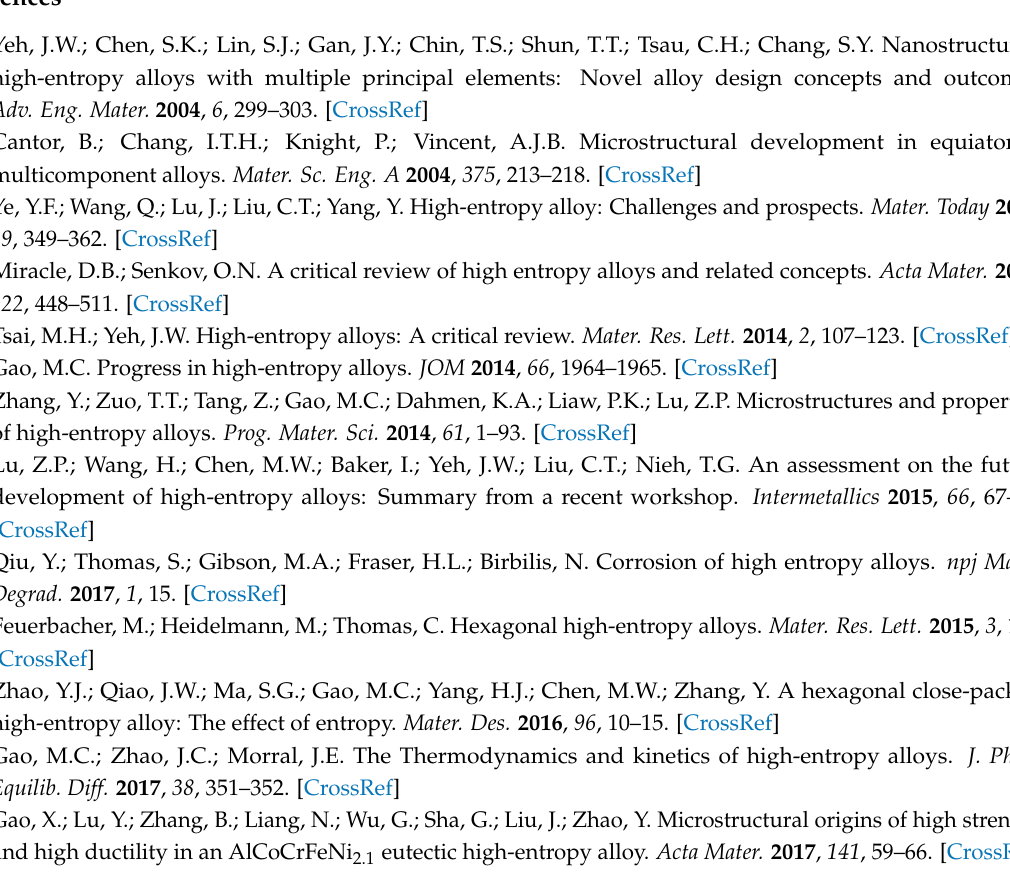
Figure S1: XRD of the melt-spun AR ribbons heated to 1118 K and the Powder Diffraction File (PDF) cards of Fe 2 B, Co 2 B, Ni 2 B, the cubic MgCu 2 (C15), hexagonal MgZn 2 (C14), and hexagonal MgNi 2 (C36) Laves phases, respectively, Figure S2: (a) XRD curves of the melt-spun AR ribbons heated to different temperatures at a heating and cooling rate of 20 K/min, and (b) the local enlarged diffraction peaks of two type of FCC phases along the zone axis (111) for the ACR sample heated to 1010 K, Figure S3: DSC curves of the melt-spun AR and ACR ribbons at a heating and cooling rate of 20